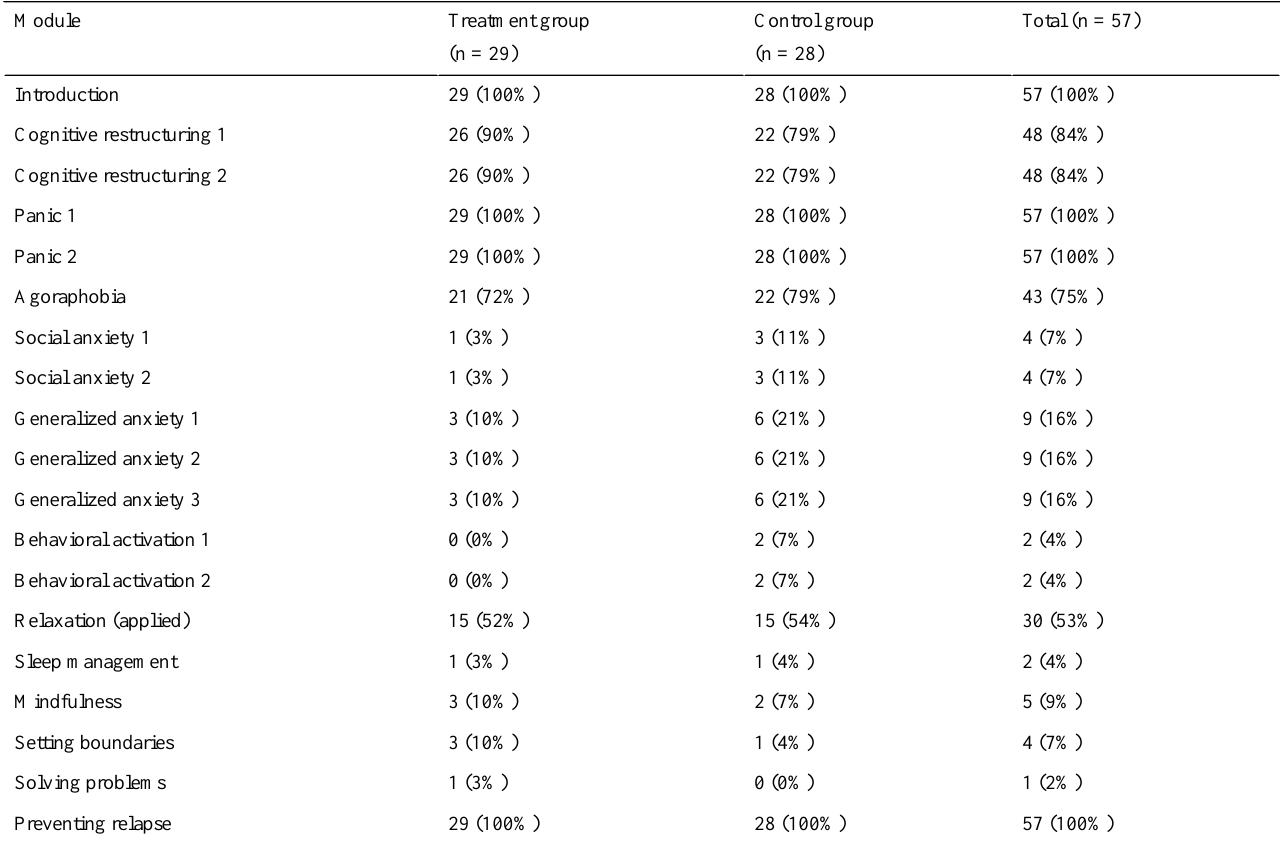
Table 2. Number of prescribed treatment